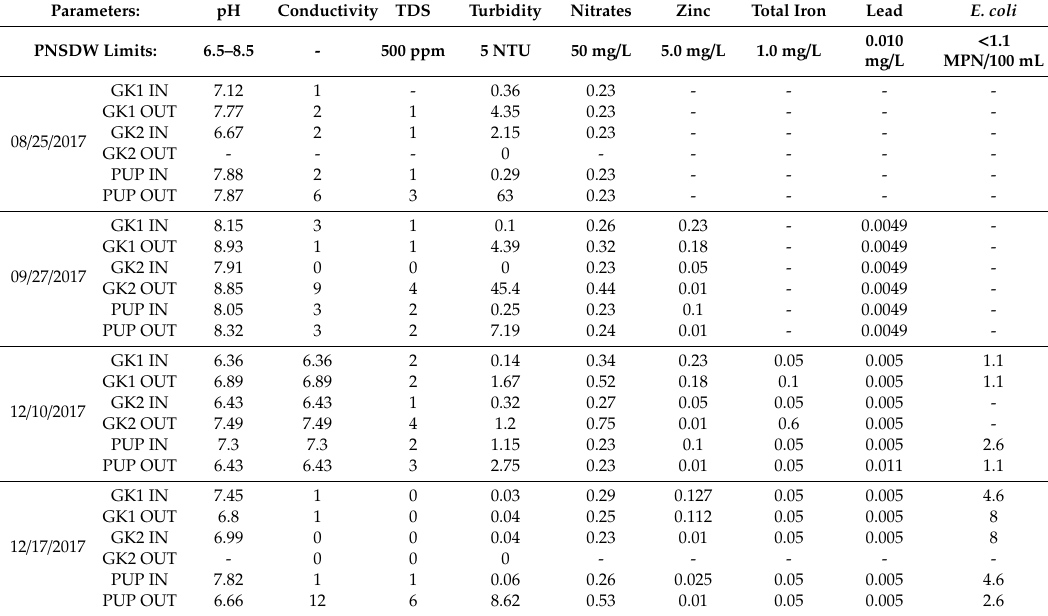
Table A1. Summary of results of RWHS and WTS rainwater quality